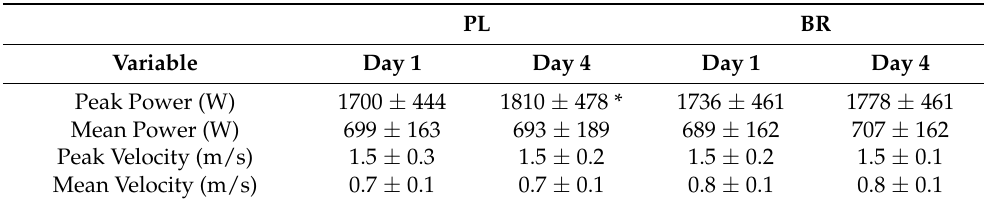
Table 7. Performance outcomes during a back squat exercise protocol for determination of power and velocity following acute and multiday nitrate supplementation. PL BR